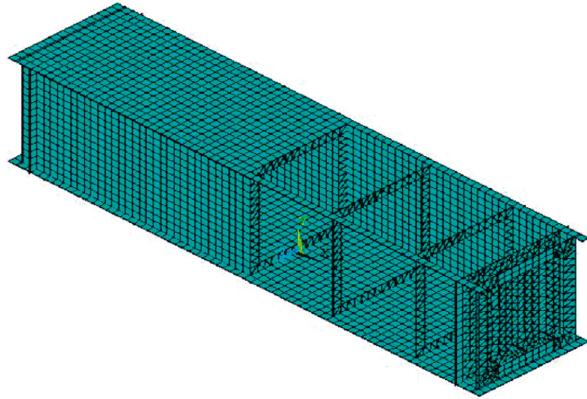
Figure 12: The finite element model of column, column support, and side